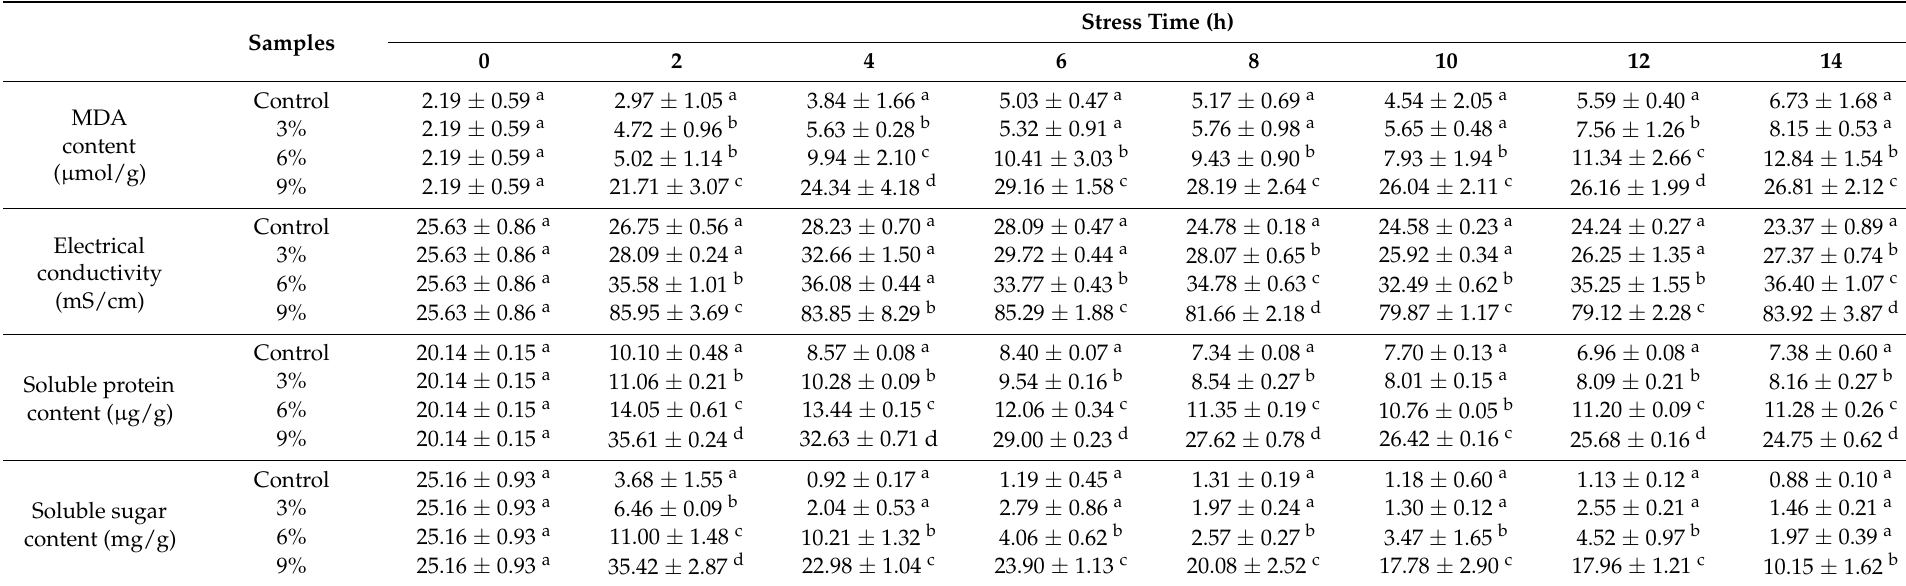
Table 1. Effects of different concentrations of ethanol stress on the MDA and extracellular leakage substances content of P. anomala NCU003.